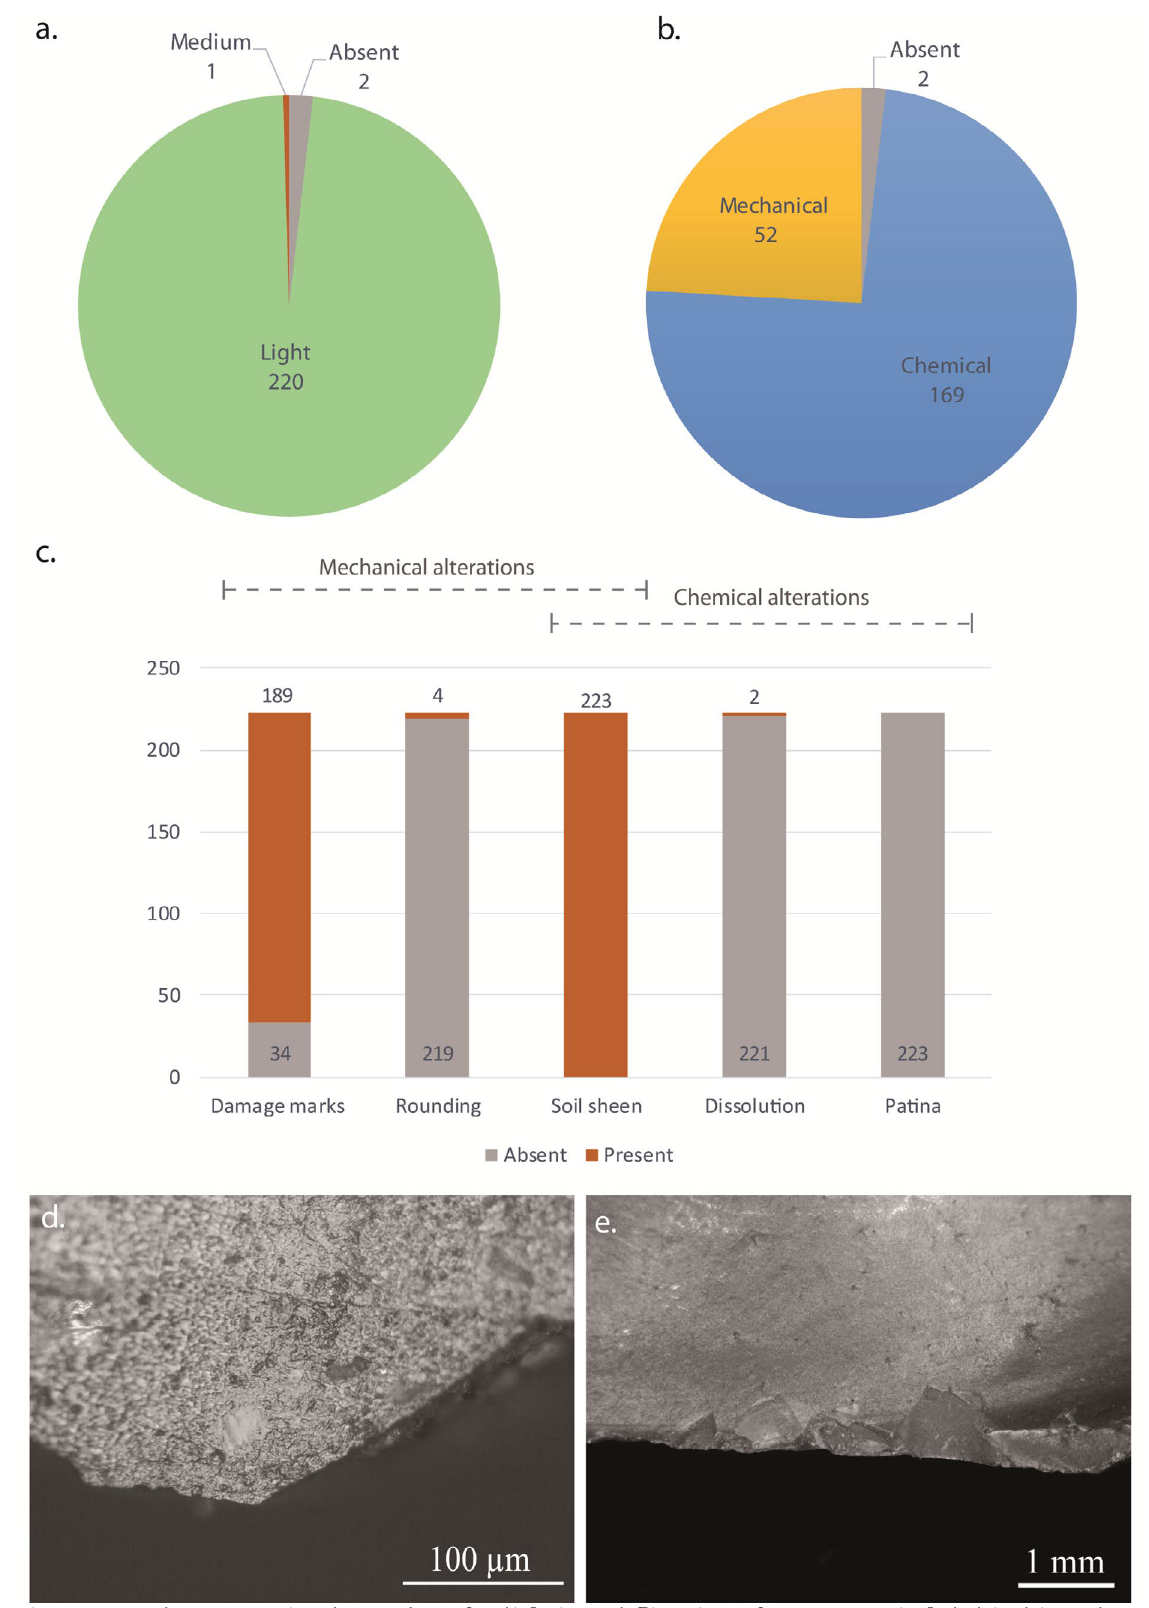
Figure 3. Graphs representing the number of radiolarite and flint pieces from MAR-1 included in this study, a. according to their degree of alteration; b. according to the main type of alteration; c. according to each type of surface alteration (a piece can exhibit several types of alteration); d. soil sheen, random striations and flat polish near edge (MAR1 1171) and e. small overlapping taphonomical scars (MAR1